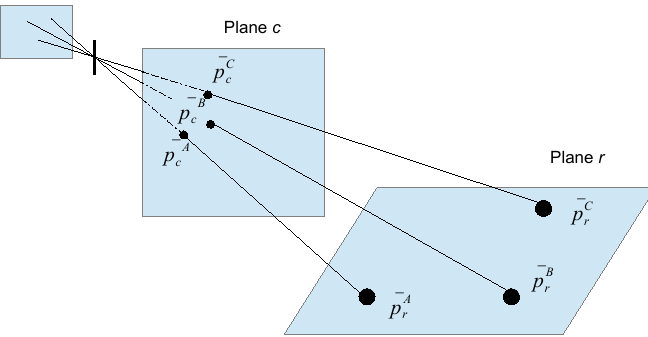
Figure 6. Pose estimator. In the figure, the ‘plane r ’ is the plane of the target and the ‘plane c ’ is a mirror plane of the sensor of the